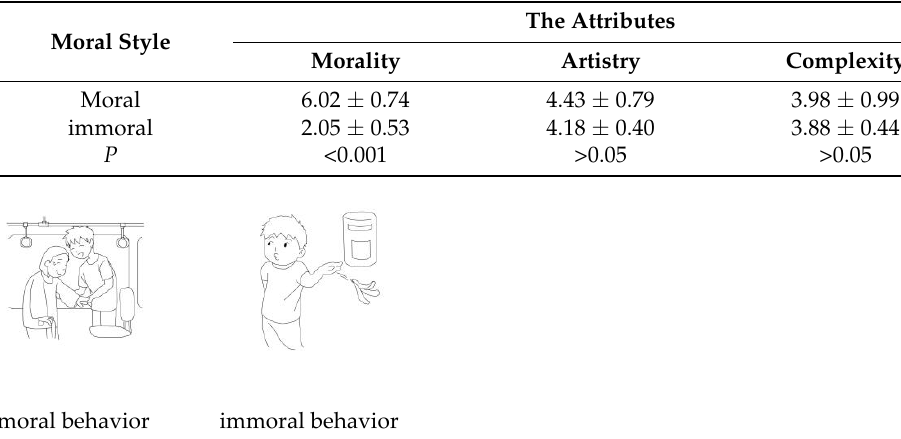
Figure 3. Example of behavioral materials used in Experiment 1.